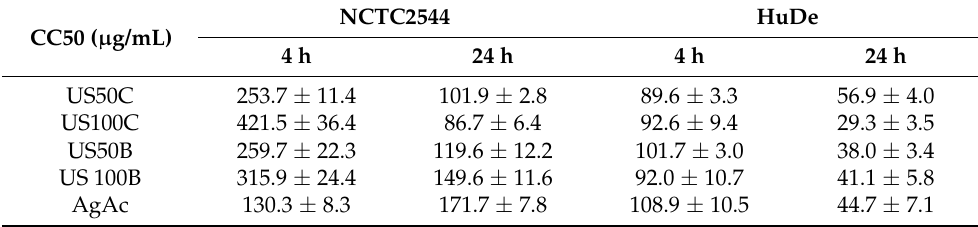
Data represent the mean ± SD of two independent